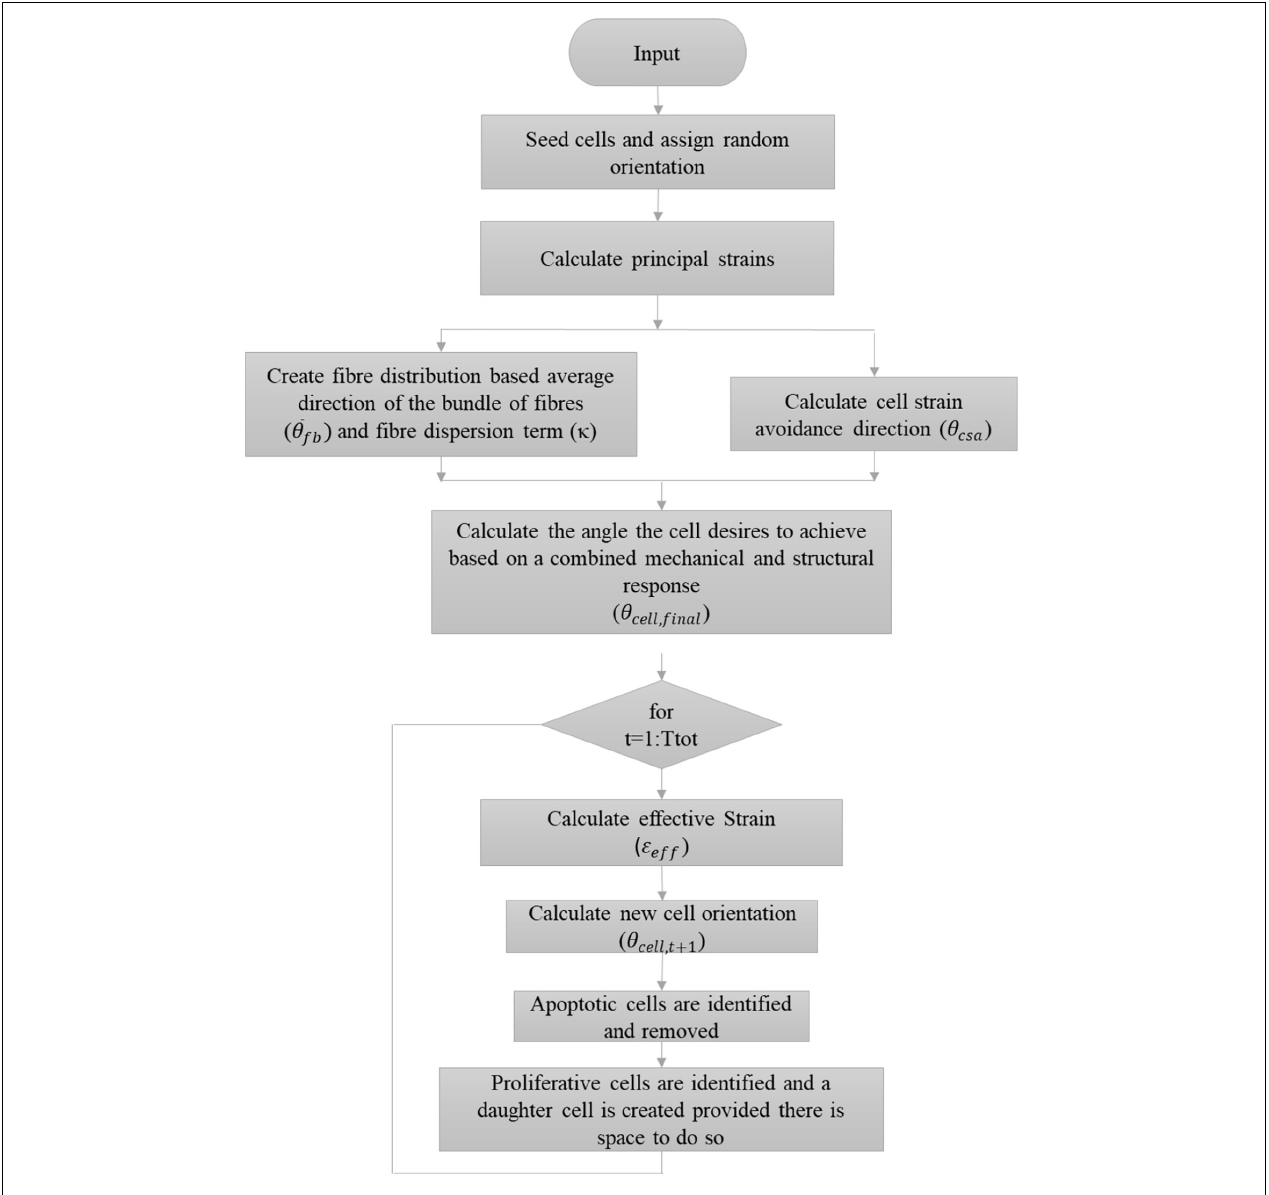
FIGURE 8 | Flowchart describing the implemented